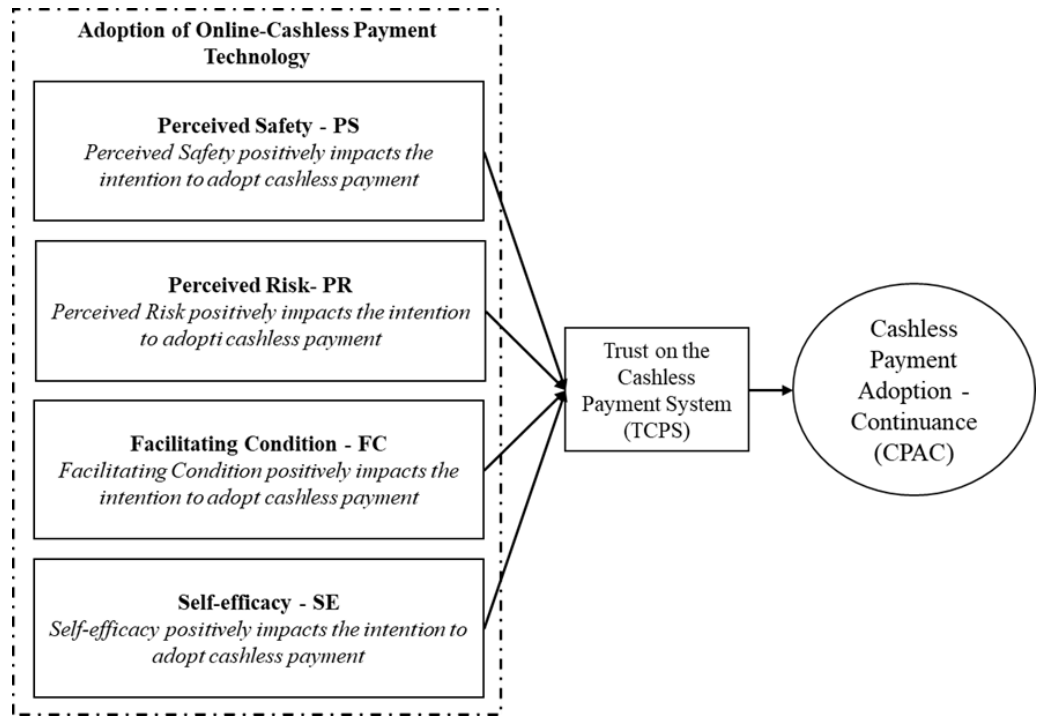
Figure 1: Research Framework (Source: Authors‟